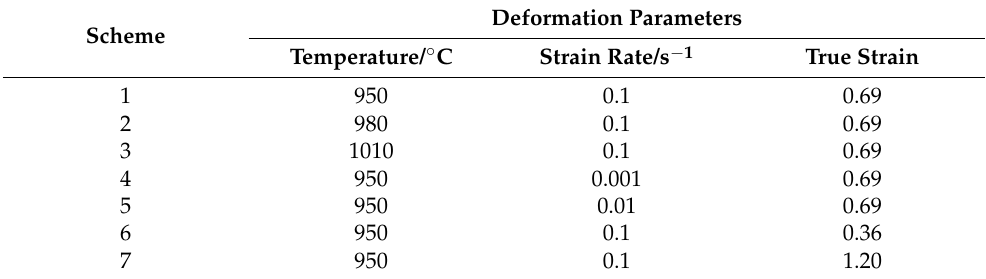
Figure 2. Microstructure of GH4169 superalloy after aging treatment: ( a ) OM map; ( b ) SEM map. (U δ represents the weight fraction of the δ phase). Table 2. Experimental scheme of hot deformation.